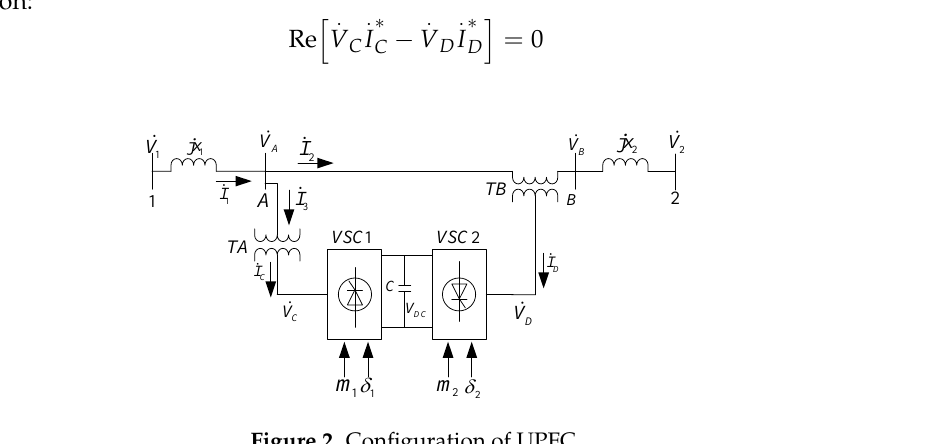
Figure 2. Configuration of UPFC.